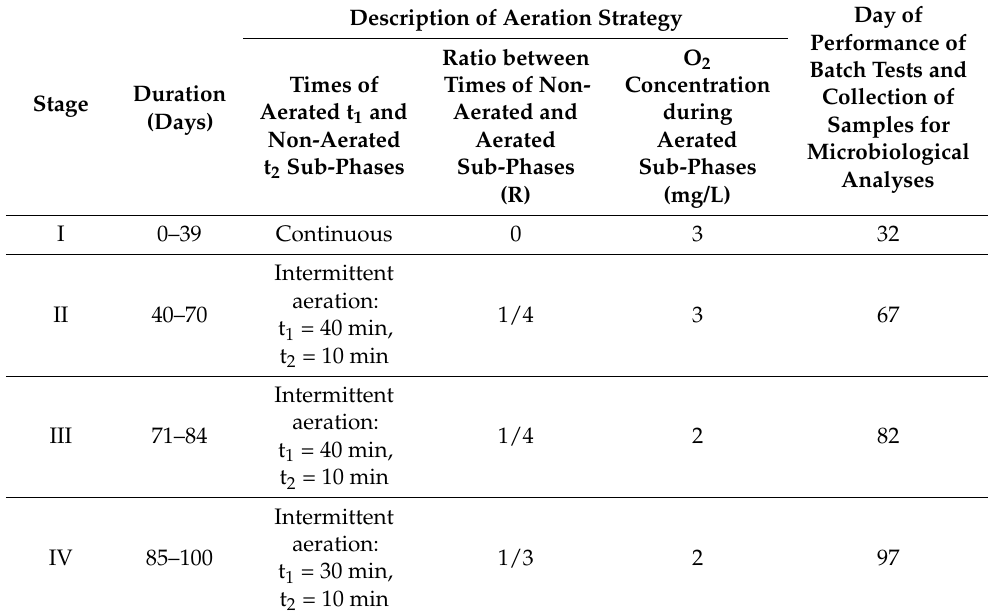
Table 1. Reactor operation